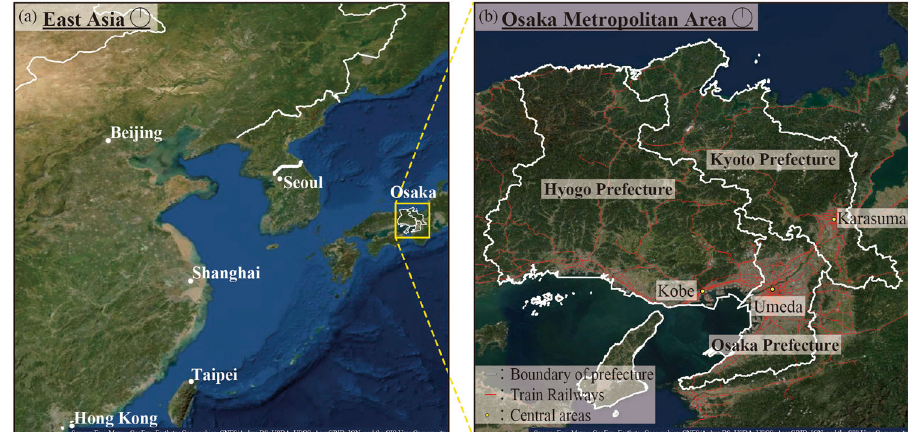
Fig. 1 Map of the Osaka metropolitan area in Japan. In this study, the Osaka metropolitan area consisted of Osaka, Kyoto, and Hyogo Prefectures. In Fig. 1, ( a ) indicates the location of Osaka metropolitan area in the East Asia, and ( b ) indicates that of three prefectures in the Osaka metropolitan area. The Osaka metropolitan area has three central areas with multiple railways. The satellite map complies with copyright 20